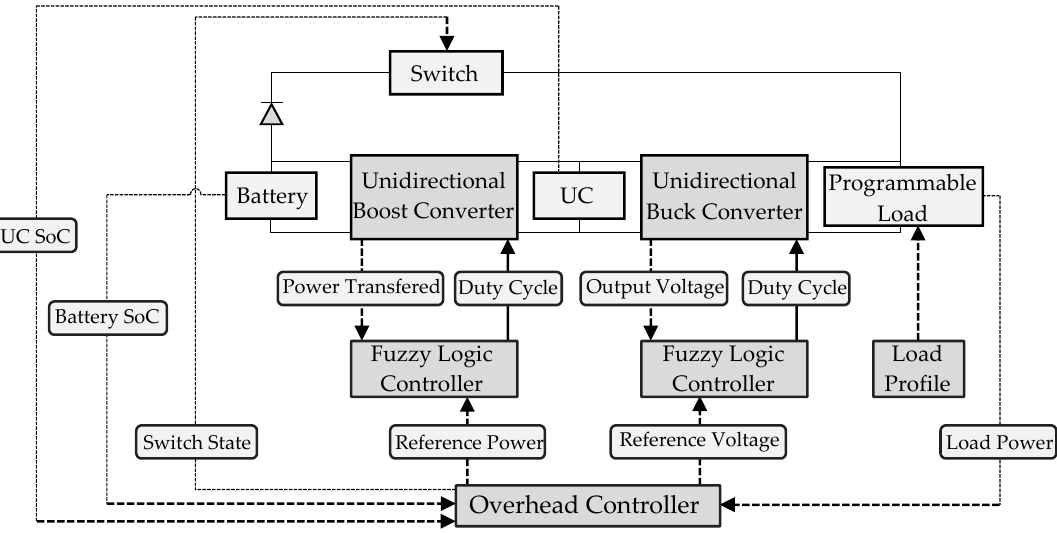
Figure 2. Overhead system design .